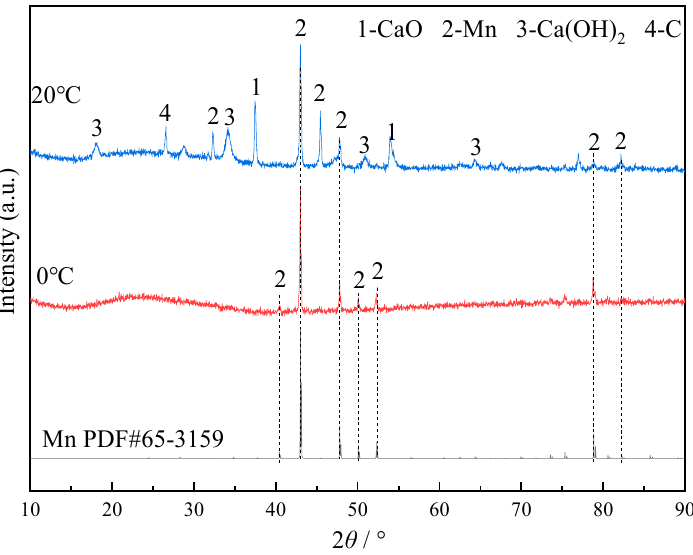
Figure 12. XRD of electro-deoxygenated products (3 V, 12 h) after cleaning at different temperatures.